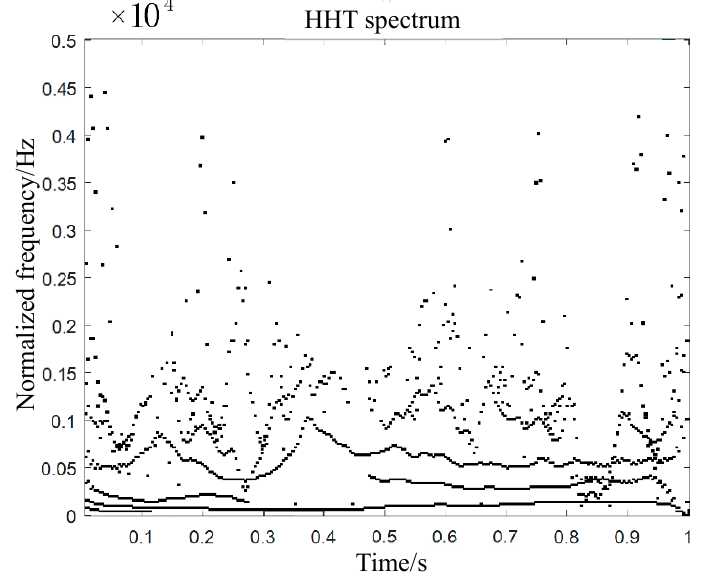
Figure 4. AE signal Hilbert–Huang transform (HHT) spectrum of carbon fiber braided composites.